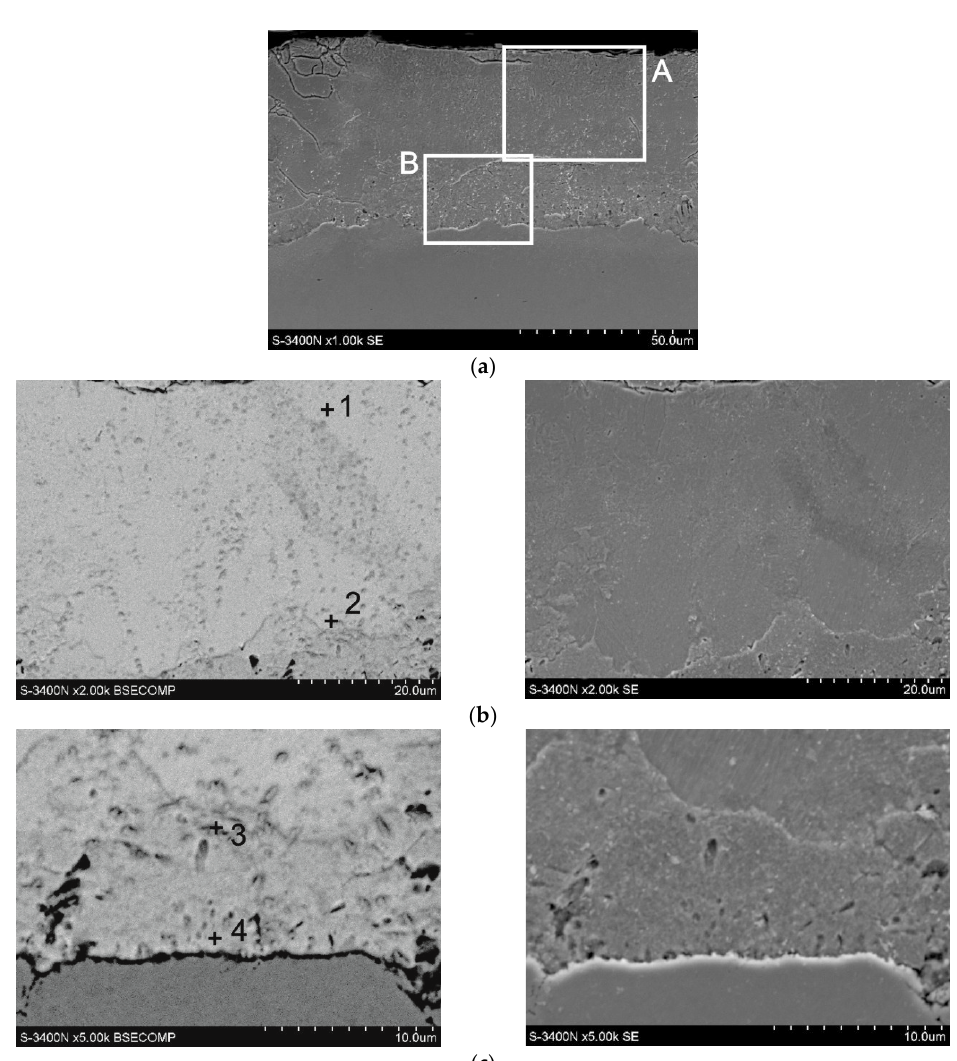
Figure 3. Microstructure (SEM) of coating obtained on high-strength grade 10.9 bolts via thermal diffusion method with reactive atmosphere recirculation: cross-section of the coating with selected areas ( a ), microstructure of the coating in area A ( b ), microstructure of the coating in area B ( c ) Table 1. Chemical composition at selected micro-areas of coating obtained on high-strength grade 10.9 bolts (measurement points acc. to Figure 3).